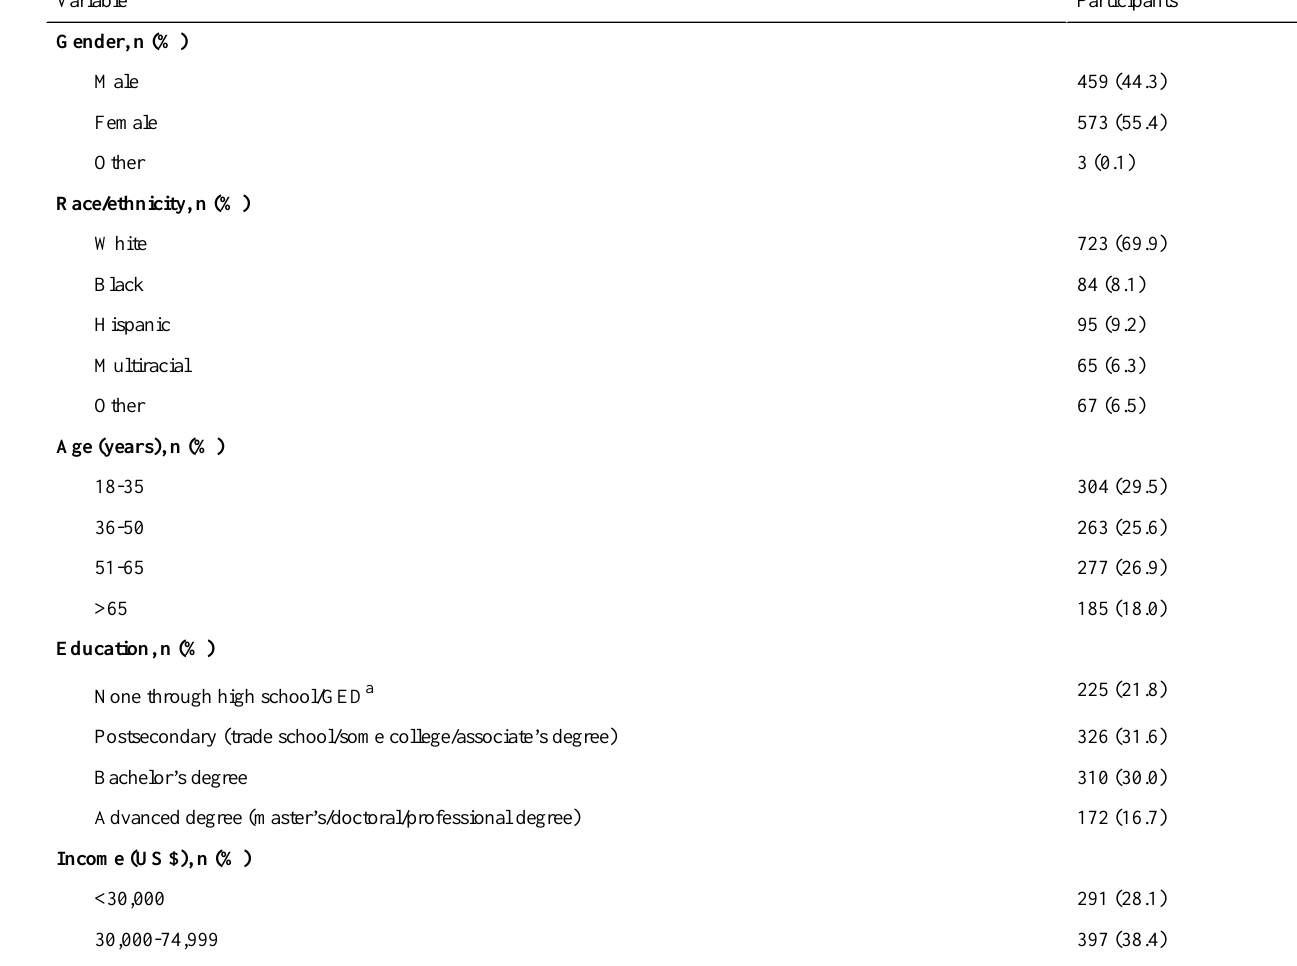
Table 1. Sample description